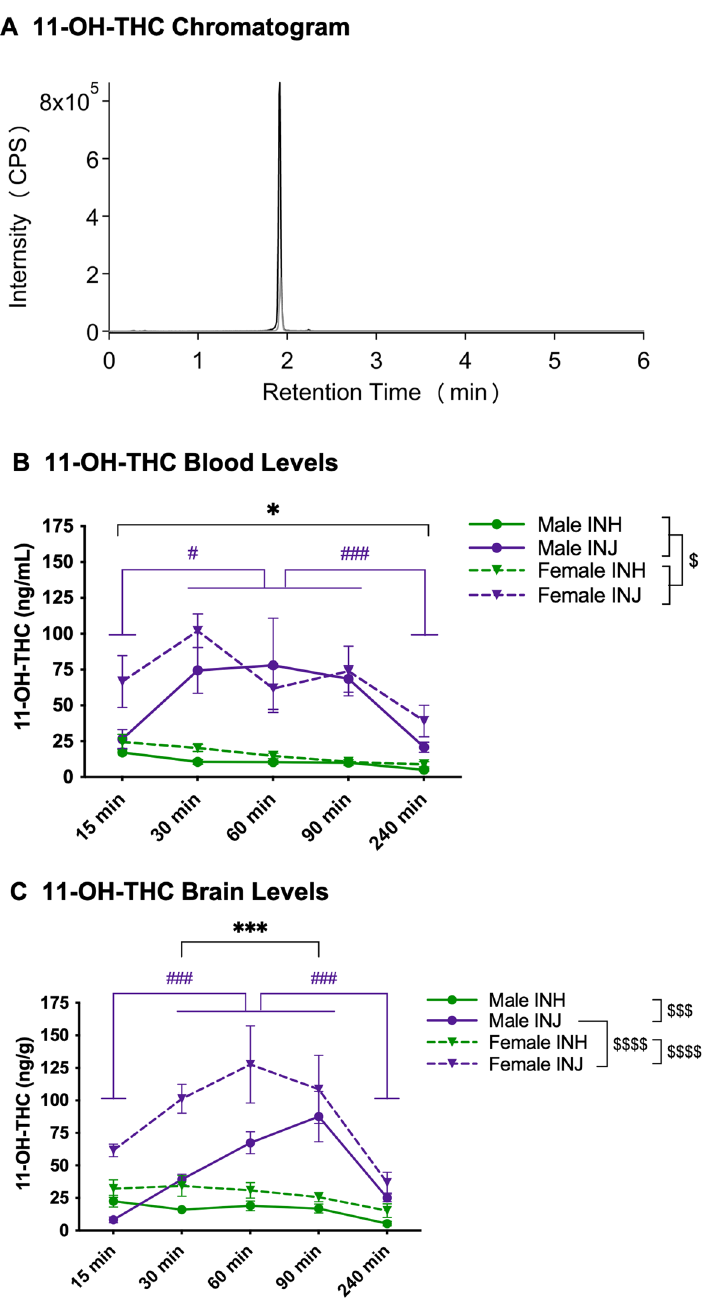
Figure 4. 11-OH-THC chromatogram and levels in blood and brain. ( A ) LC-MS Chromatogram: 11-OH-THC (black line) and 11-OH-THC-d3 (grey line) peaks at 2.0 min. ( B ) Blood levels: data are presented as mean ± SEM; n = 5–6 for each group. Presence of (*) indicates an administration difference with INH < INJ at all timepoints at * p < 0.05. Presence of ( # ) indicates a timepoint difference with purple lines indicating an INJ difference where INJ-15 < INJ-30, 60, and 90 at # p < 0.05 and INJ-240 < INJ-30, 60, and 90 at ### p < 0.001. Presence of ( $ ) indicates a sex difference; specifically, females > males at $ p < 0.05. ( C ) Brain levels: data are presented as mean ± SEM; n = 5–6 for each group. Presence of (*) indicates an administration difference with INH < INJ at 30, 60, and 90-min at *** p < 0.001. Presence of ( # ) indicates a timepoint difference with purple lines indicating an INJ difference where INJ-15 and 240 < INJ-30, 60, and 90 at ### p < 0.001. Presence of ( $ ) indicates a sex difference; specifically, male-INH < male-INJ at $$$ p < 0.001, female-INH < female-INJ at $$$$ p < 0.0001, and male-INJ < female-INJ at $$$$ p <